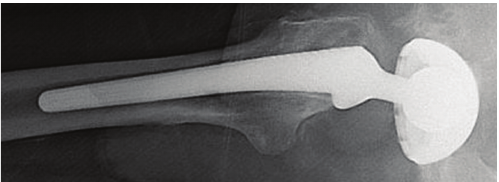
Figure 2: Lateral X-ray shows medial migration of the femoral head within the acetabular shell and excludes a dislocation as it confirms the prosthetic femoral head lies within the acetabular shell on a tangential